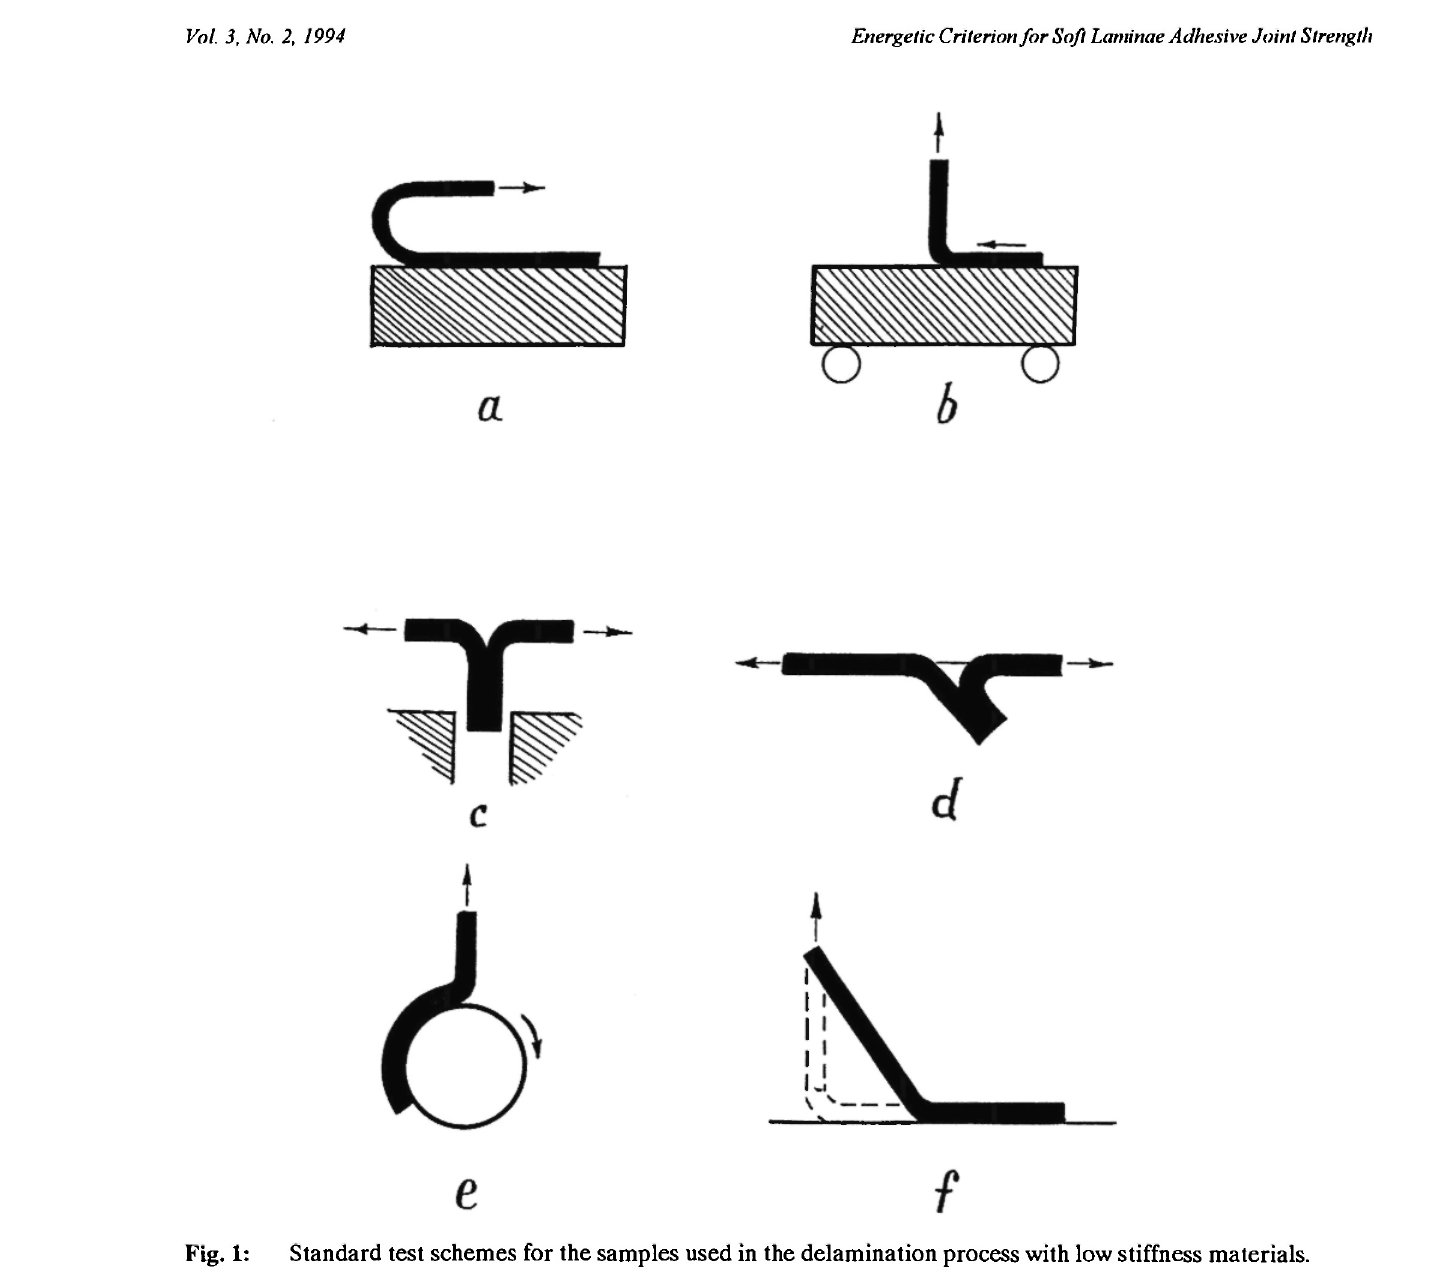
Various methods for determination of Ρ are used in accordance with the applied standard instructions (maximal height of the load-displacement diagram, arithmetic or weighted average of the value of Ρ on it,